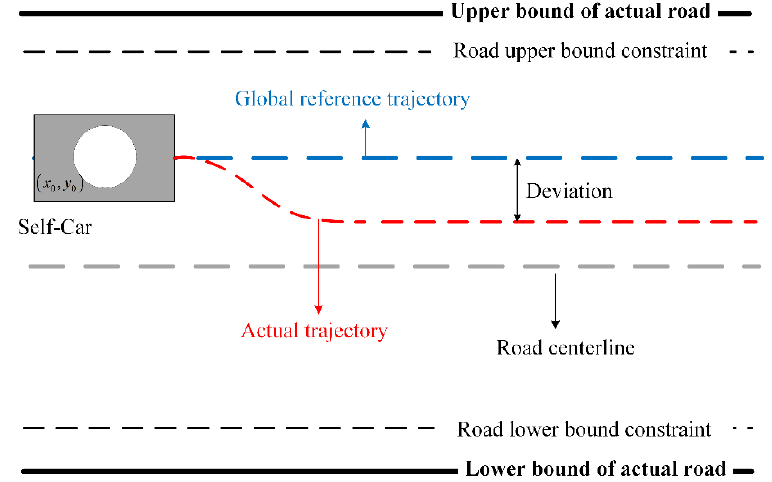
Figure 9. Cost caused by road bounds.